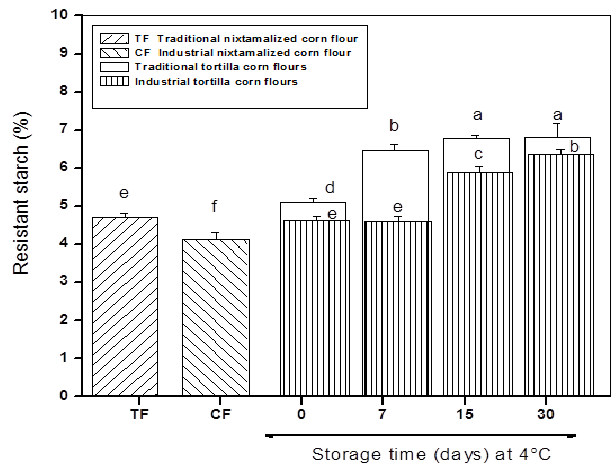
Figure 1. Resistant starch contents in traditional and commercial corn flours and corn tortilla flours. The values represent the mean ± standard deviation (SD), n = 5. Means in bars with different letters differ significantly (p ≤ 0.05 ).